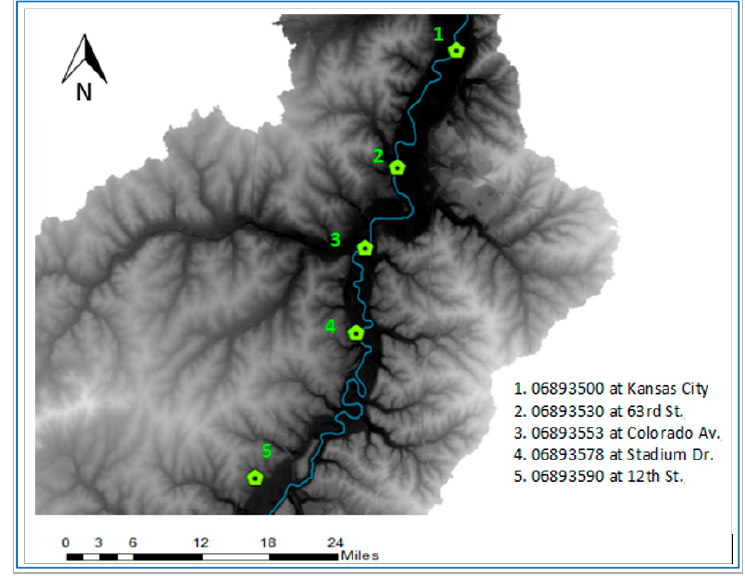
Figure 5. Location of USGS Gaging Stations used in the calibration.